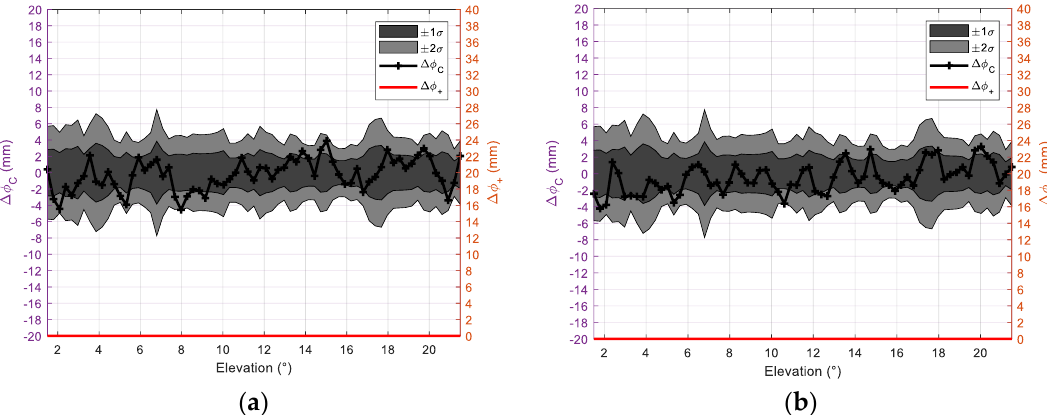
Figure 5. Examples of phase shift from two no-rain days: ( a ) on 8 June 2015; ( b ) on 3 August 2015.